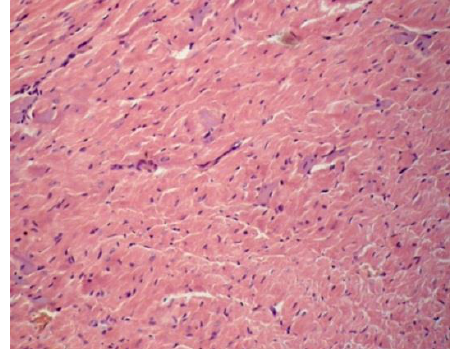
Fig. 4. Ventricles of rat myocardium. SHR rat control group. Myocardial wall hypertrophy. Hematoxylin and eosin staining. Eye. 10×. Lens. 10×.